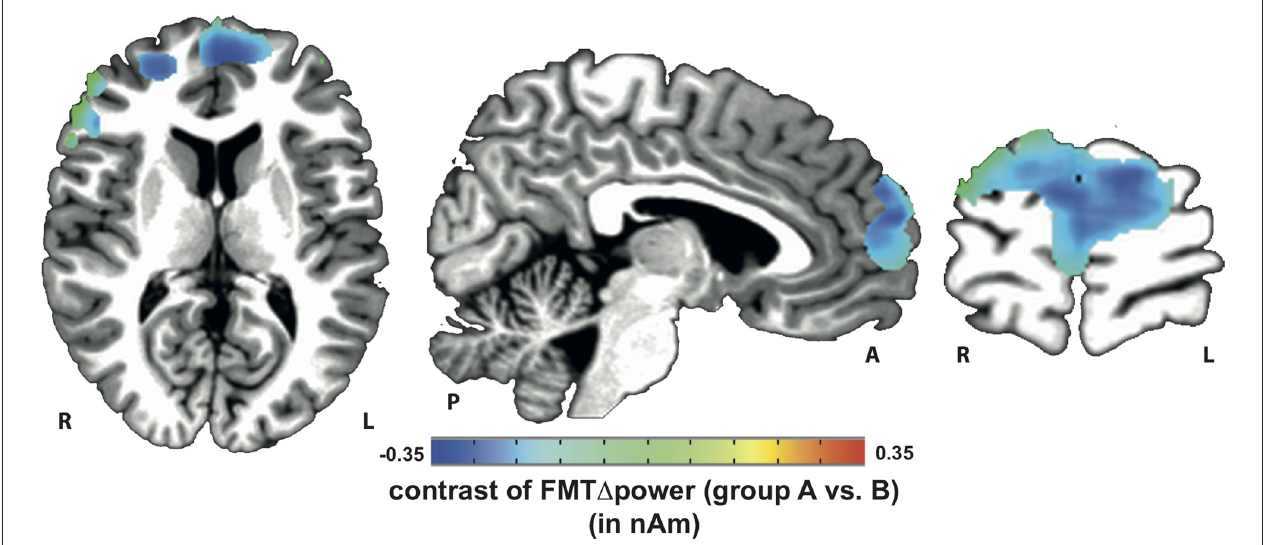
FIGURE 5 | Topographic map of voxels showing significant contrast in FMT ∆ power when comparing 2-back task-related theta power increase during tACS vs. sham stimulation . Lack of theta power increase was found throughout the whole n -back task-related frontal cortical areas.